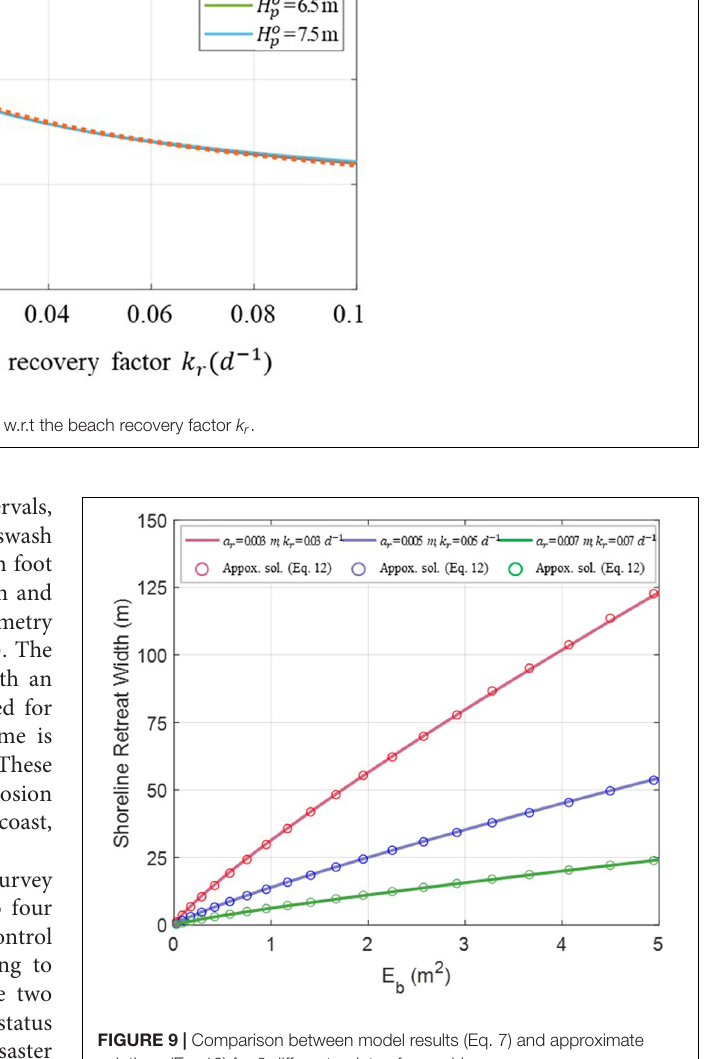
FIGURE 9 | Comparison between model results (Eq. 7) and approximate solutions (Eq. 12) for 3 different points of a r and k r